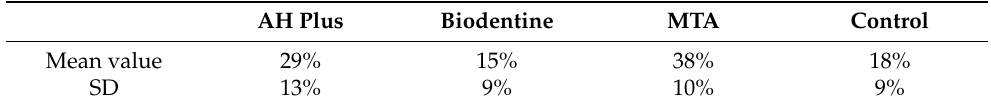
Figure 1. Microbial adhesion and growth of oral microorganisms on AH Plus, Biodentine, MTA, and bovine dentin. The graphs show the number of CFUs which demonstrate the antimicrobial effect of the tested material surfaces on aerobic ( A ) and anaerobic ( B ) bacteria after an exposure time of 2 h in the oral cavity. Bovine dentin served as a negative control, while AH Plus, Biodentine, and MTA served as the material test surfaces. The CFU values were shown on a log 10 scale per cm 2 (log 10 /cm 2 ). The standard deviations and p values of the significantly different data are marked on the graphs. Table 2. The proportion of adherent microorganisms in relation to the surface area of the material and control samples after DAPI staining and fluorescence